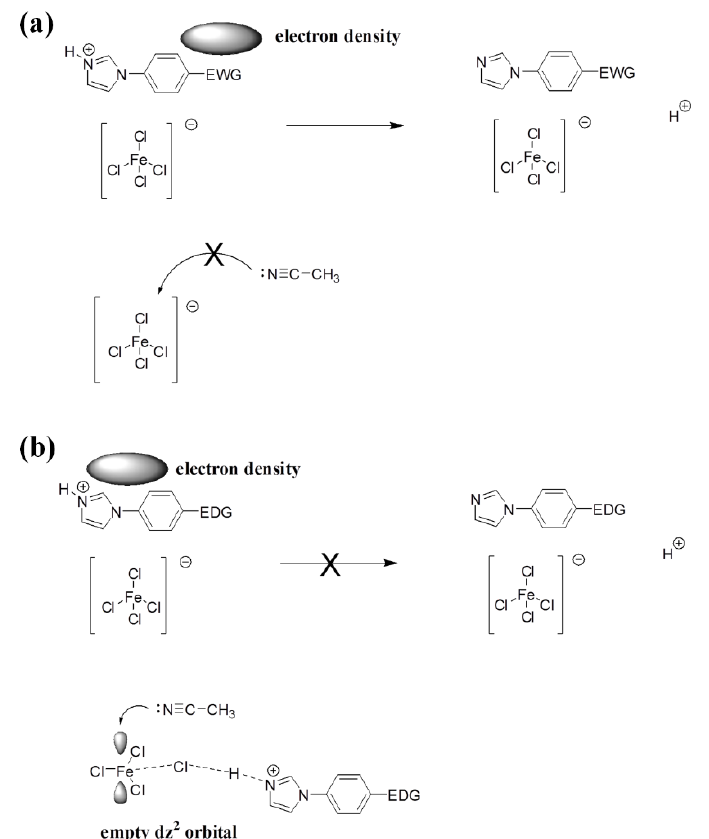
Figure 7. FTIR spectra of pure acetonitrile and B-L MIL + acetonitrile